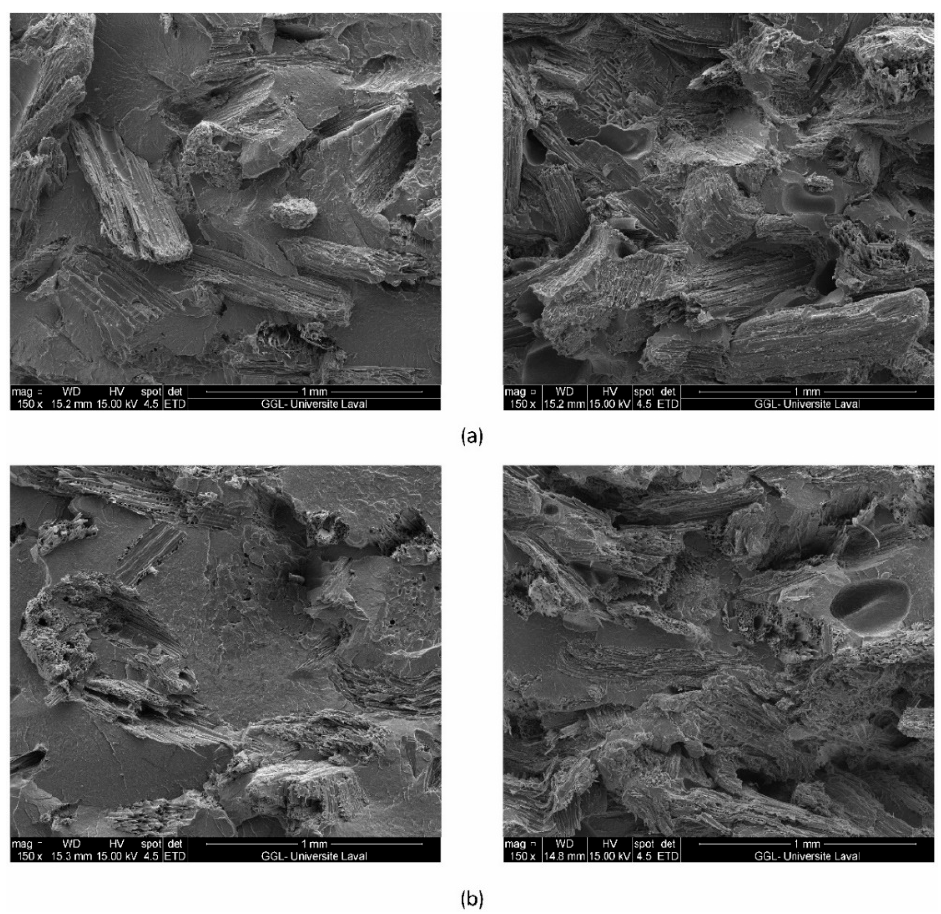
Figure 7. Scanning electron microscope (SEM) images of the recycled high-density polyethylene and maple fiber composite cross-sections with 30 wt% (left column) and 60 wt% (right column) for ( a ) untreated and ( b ) treated fibers.